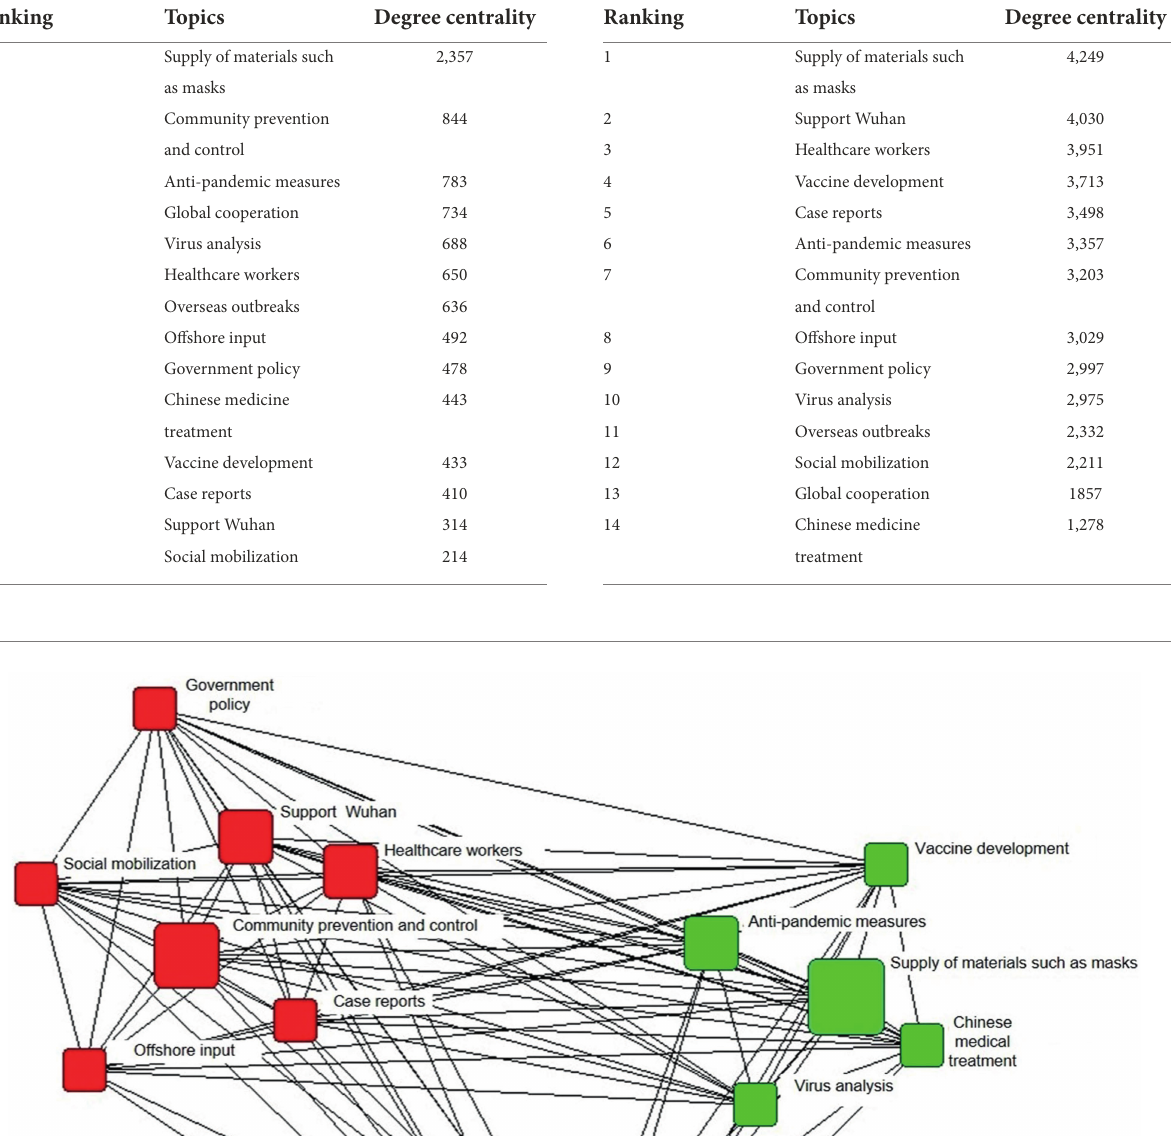
TABLE 7 Explicit public agenda topic ranking. TABLE 8 Implicit public agenda topic ranking.